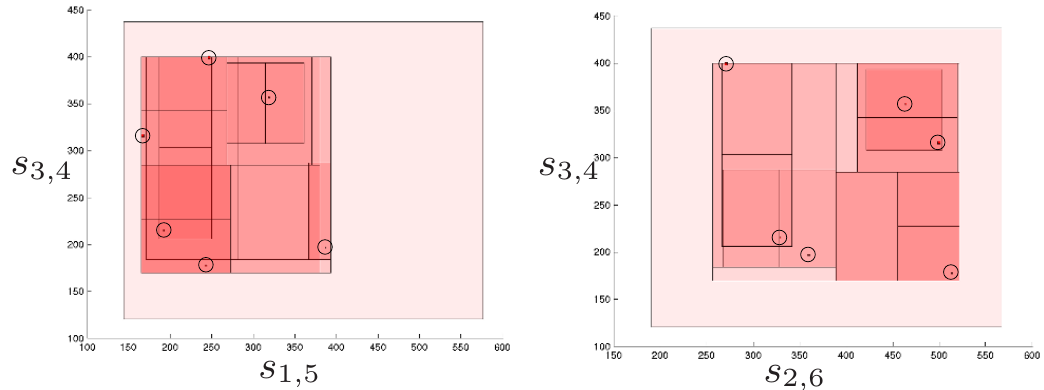
Figure 11. Two views of the boxes processed to isolate the six valid poses of the octahedral manipulator. The solutions are the encircled tiny boxes. The initial box, i.e., the lighter red box, is reduced and split until the six solutions are properly isolated. It can be appreciated that only few of the processed boxes include no solution, i.e., they are empty boxes.